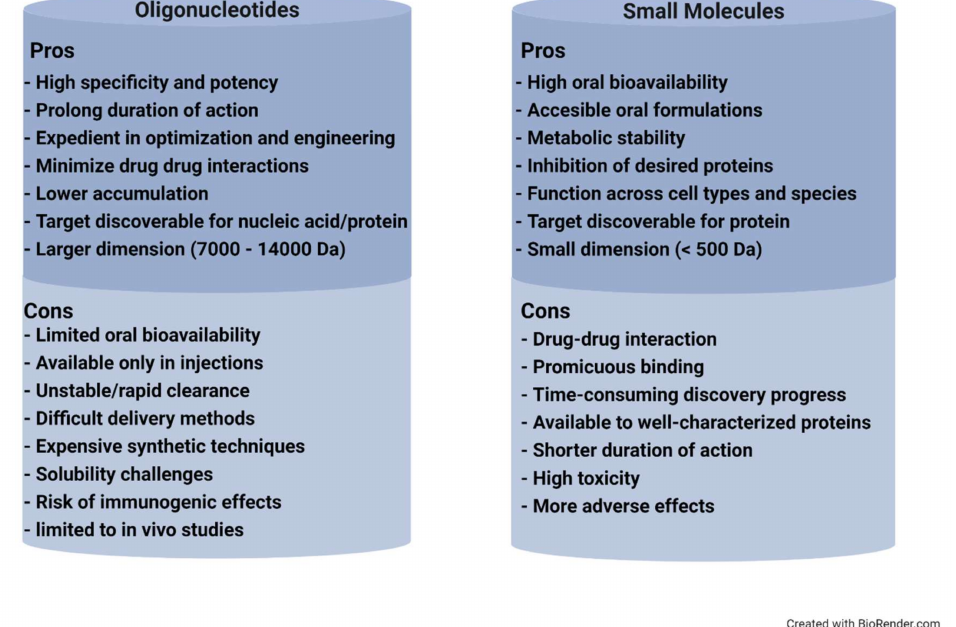
Figure 1. Pros and cons comparison of oligonucleotide versus small molecule drugs. Some high- lighted advantages of oligonucleotide would be inhibitory specificity, expedient manufacture, and low in drug–drug interaction. Disadvantages of cost, stability, and formulation